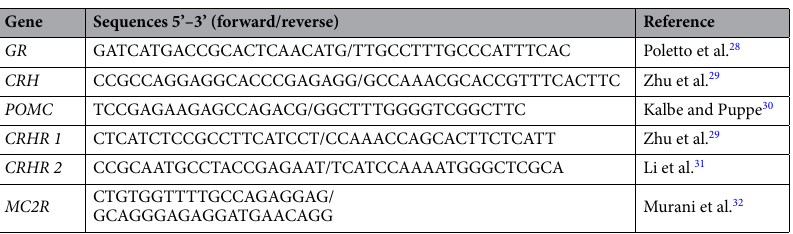
Table 1. Primers used for real time polymerase chain reactions. GR glucocorticoid receptor, CRH corticotropin-releasing hormone, POMC proopiomelanocortin, CRHR 1 corticotropin-releasing hormone receptor 1, CRHR 2 corticotropin-releasing hormone receptor 2, MC2R melanocortin 2